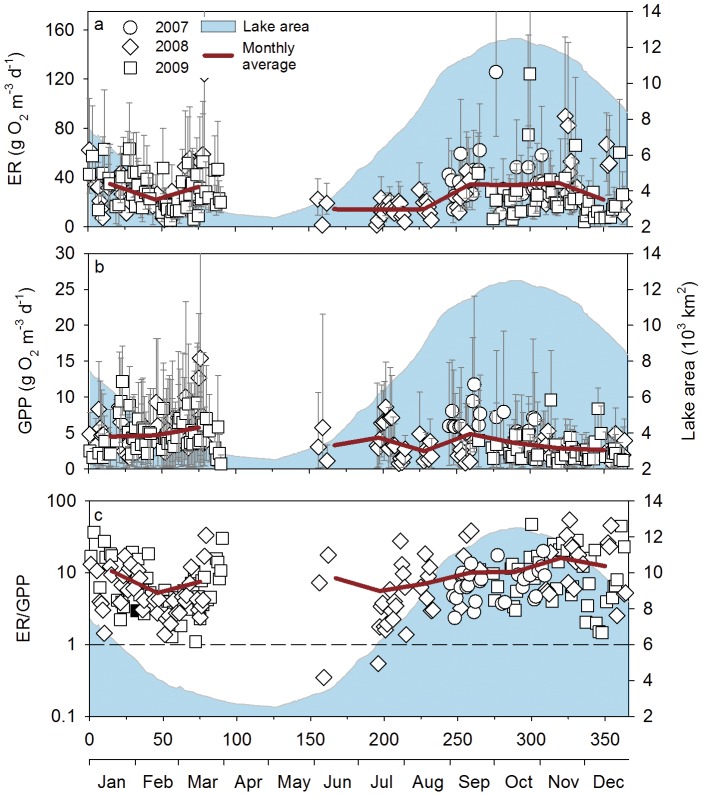
Ecosystem metabolism estimates for the Chong Khneas site (9/2007 to 4/2009).Data points are daily estimates from the Bayesian state-space model thinned to only include days where diel changes in oxygen were sufficient to produce reliable values. Each point is the median of the posterior distribution for a given day with error bars indicating the 95% credible interval. The red lines are the monthly mean. Also shown is modeled lake area as described in Figure 1.